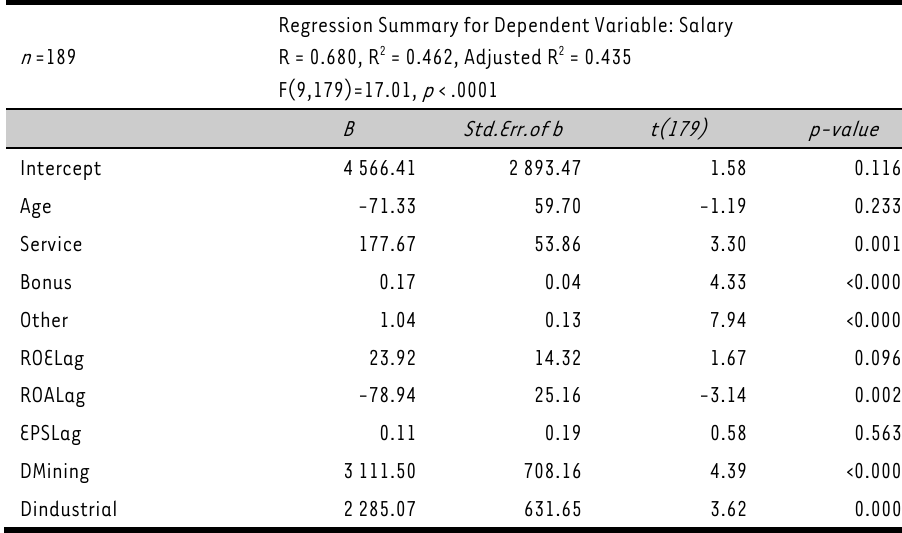
TABLE 2: Econometric Model 1 showing salary as the dependent variable with lagged ROE, ROA and EPS Regression Summary for Dependent Variable: Salary R = 0.680, R 2 = 0.462, Adjusted R 2 = 0.435 n =189 F(9,179)=17.01, p < .0001 B Std.Err.of